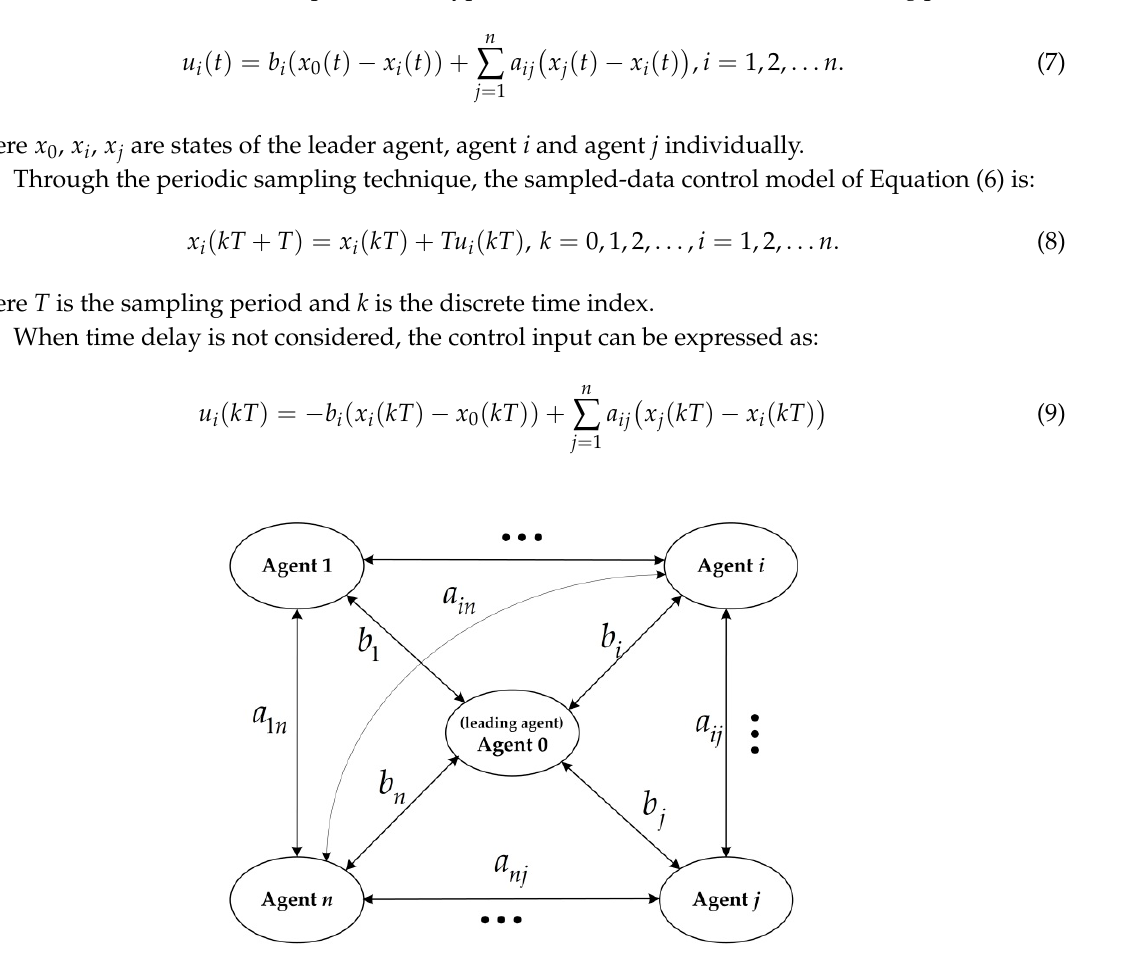
Figure 5. Undirected communication network of leader-following multi-agent systems.